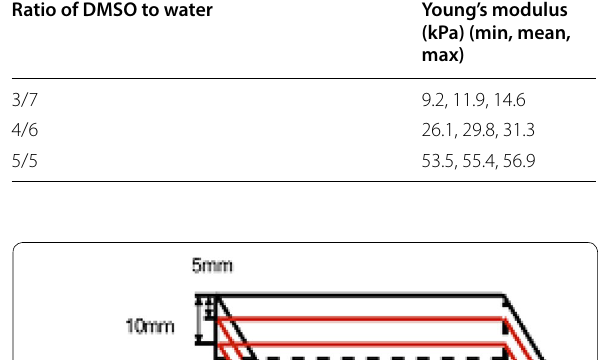
Table 1 Characteristic of PVA hydrogel Ratio of DMSO to water